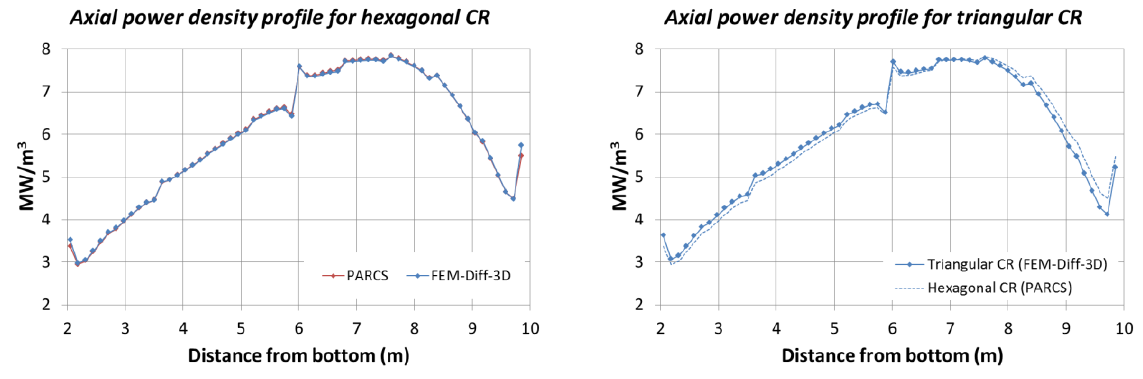
Figure 4. Radially integrated axial power density profiles for the hexagonal (left) and triangular (right) con- trol rod model obtained with FEM-Diff-3d (blue) and PARCS